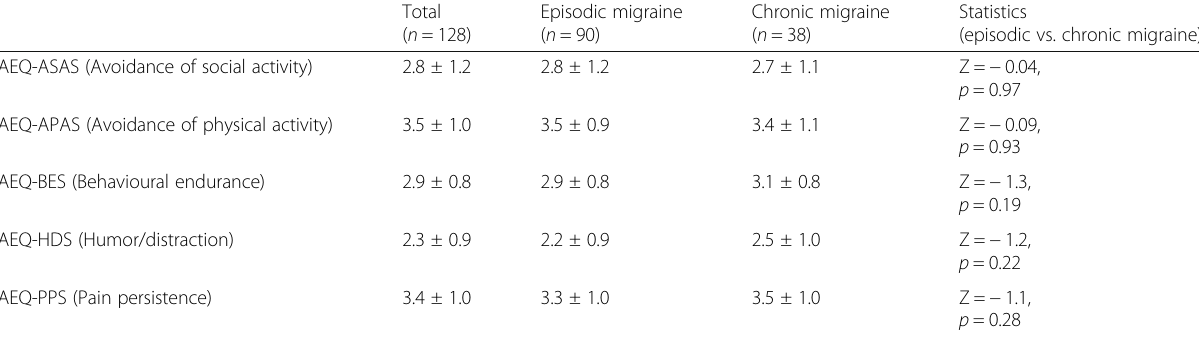
Table 2 Avoidance and endurance behaviour scores (AEQ behavioural scores)